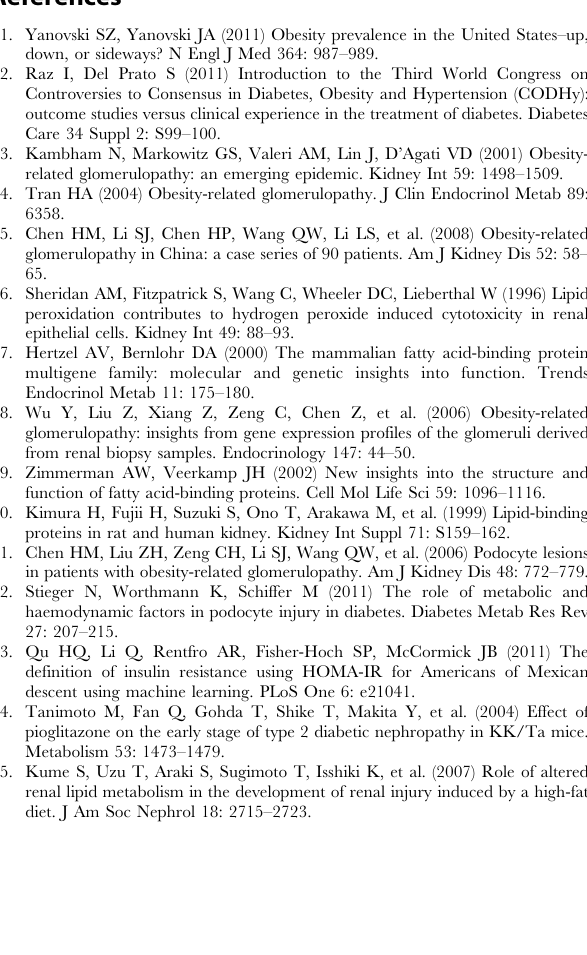
Table S1 Clinical characteristics of patients with idio- pathic FSGS and patients with ORG, compared with healthy